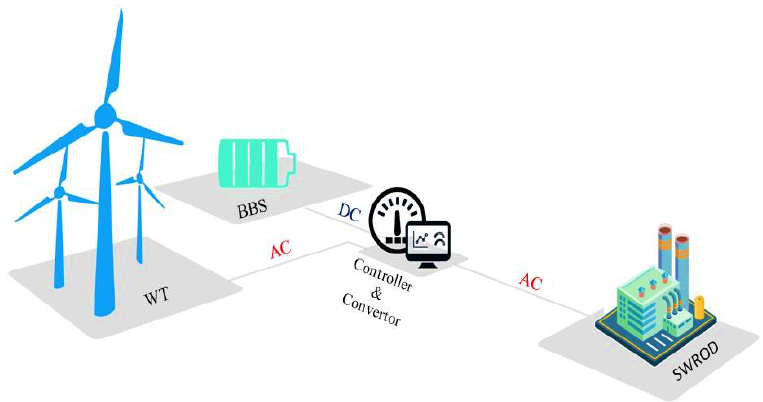
Figure 1. Developed configurations for freshwater production in the current study.